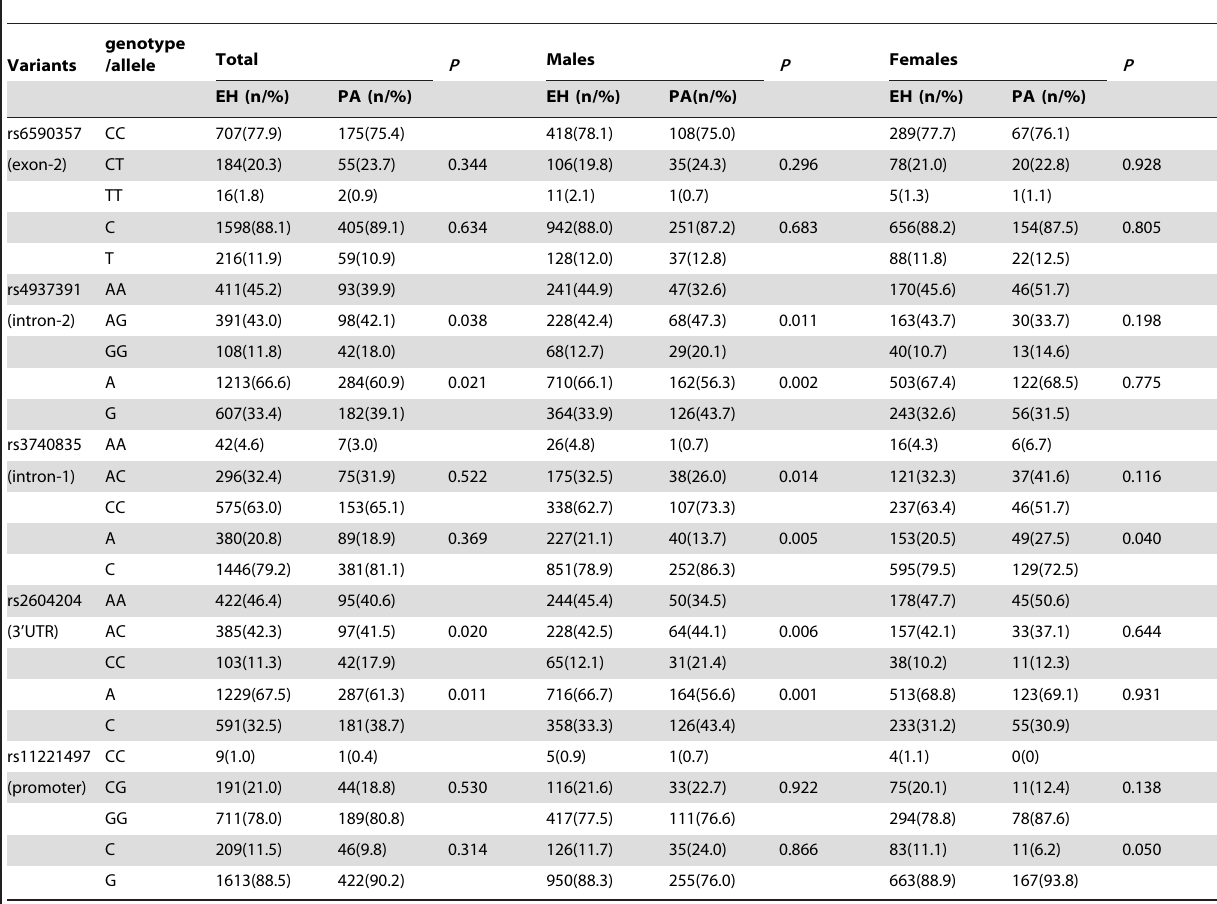
Table 2. Genotype and allele frequencies in PA and EH patients.